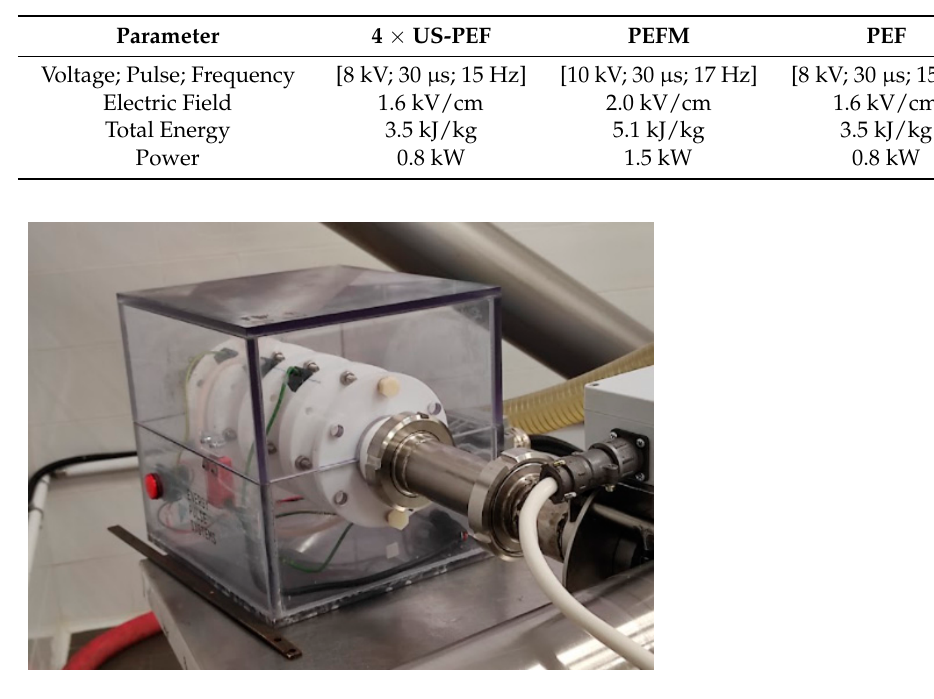
Figure 1. 4 x US devices . Figure 1. 4 × US devices.